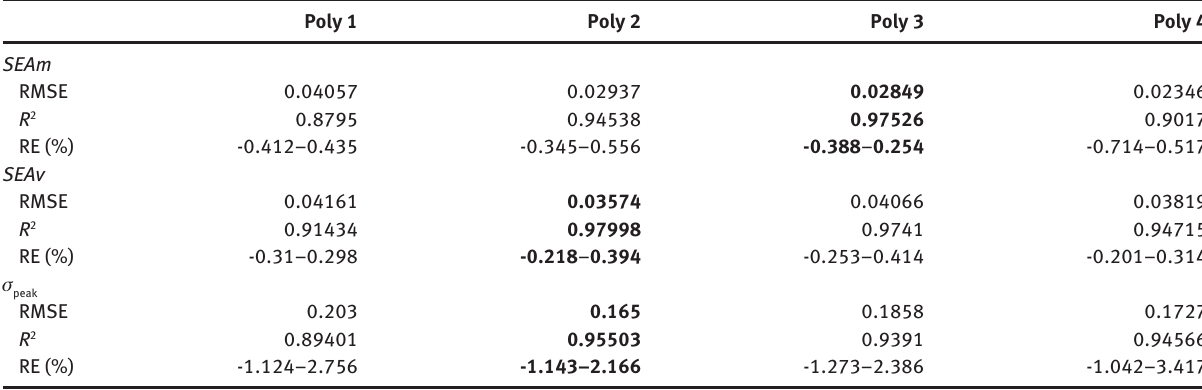
Table 6: Accuracy of different polynomial RSM models for R0-HSP.